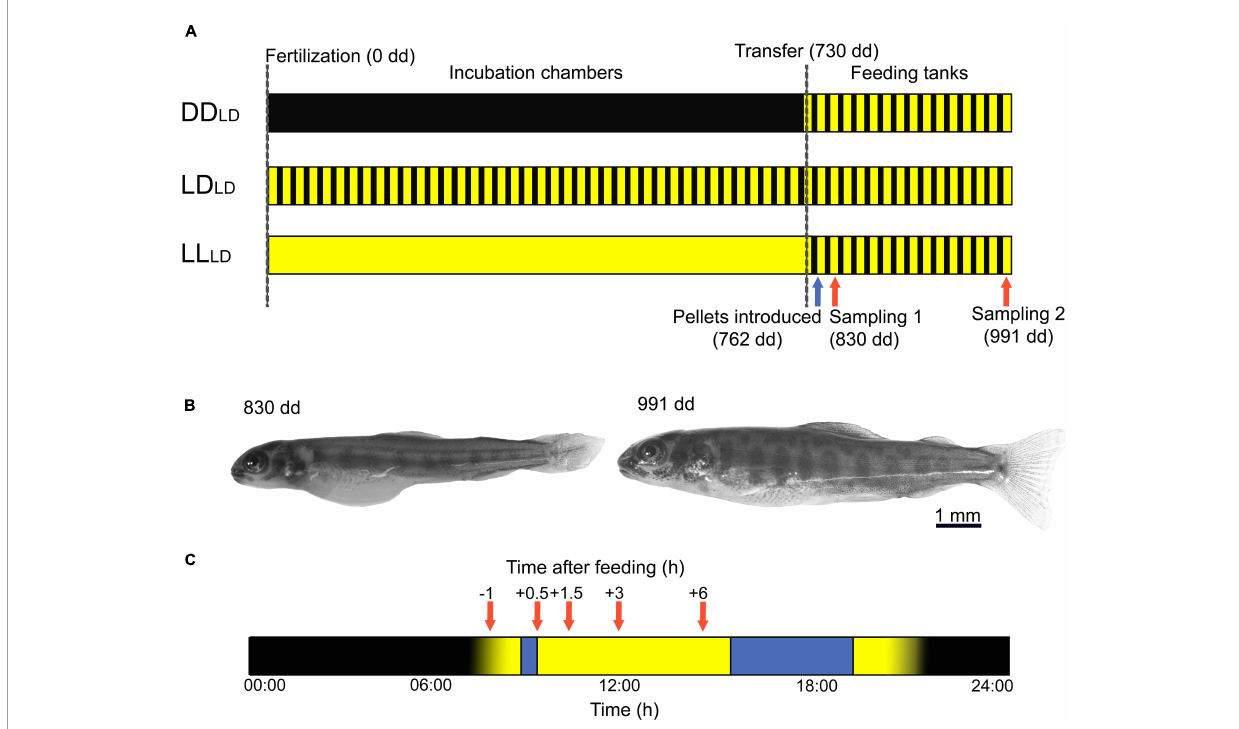
FIGURE1 Experimental design and sampling of first feeding Atlantic salmon. (A) Atlantic salmon were reared under three different light conditions: constant darkness (DD), 14 h light-10 h dark (LD), and constant light (LL) from fertilization (dashed line, 0 dd) until 1 week before the onset of exogenous feeding when alevins were transferred to feeding tanks (dashed line, 730 dd). In the feeding tanks, the light was set to 14:10 LD for all tanks, and pellets were first introduced at 762 dd (blue arrow). Fish were sampled at 1 (830 dd) and 3 weeks (991 dd) after the onset of exogenous feeding (red arrows). (B) First-feeding Atlantic salmon alevin with yolk sac at 830 dd; and Atlantic salmon fry with clear cryptic (spotted) coloration at 991 dd. (C) The timeline of the sampling days is shown in hours, from 00:00 to 24:00. The light was switched on at 08:00. Fish were fed twice a day (blue box) and sampled (red arrows) before ( − 1 h) and after (0.5, 1.5, 3, and 6 h) the first meal of the day (9:00–9:30). Blue box: Feeding period. Red arrows: sampling time points. Yellow: Lights on. Black: Lights off. dd,